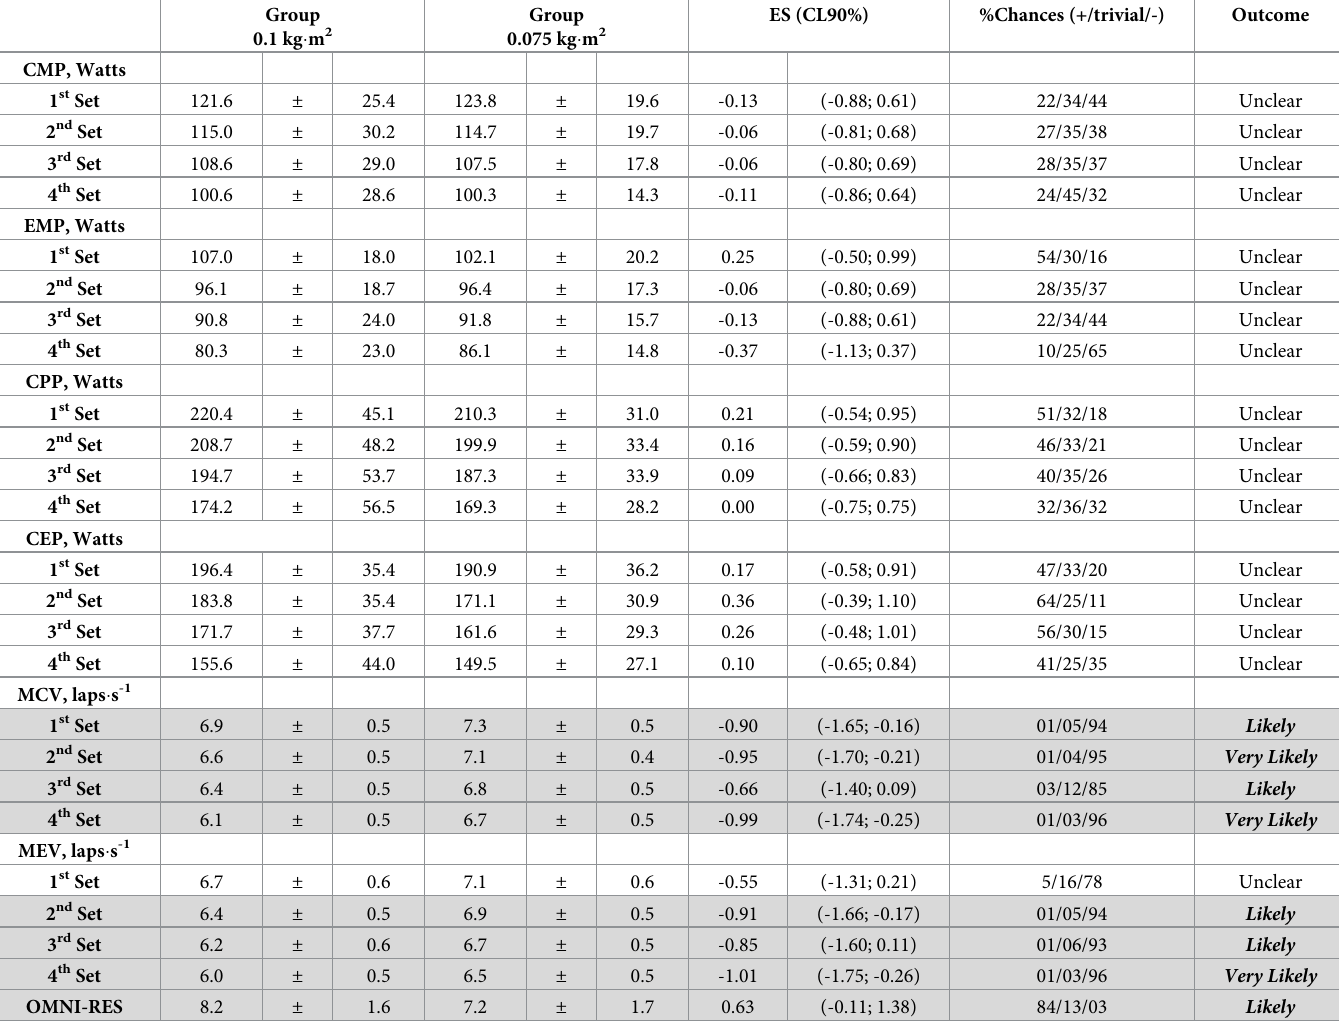
Table 3. Comparison of the power and velocity output during iso-inertial exercise in the 0.1 kg � m2 and 0.075 kg � m 2 groups. Group 0.1 kg � m